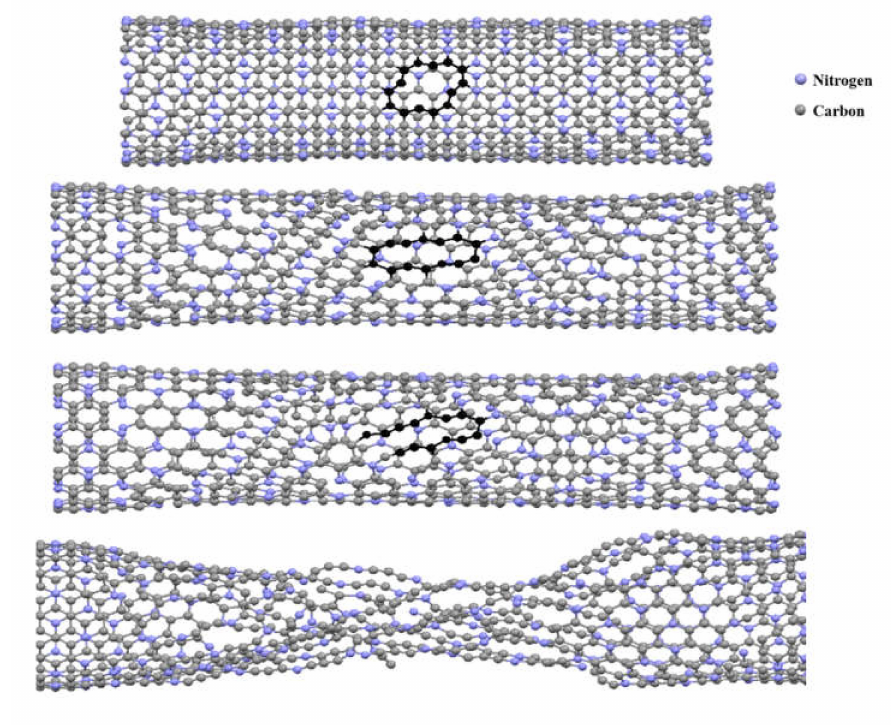
Figure 14. Snapshot of the failure process of a (10,10) armchair C 3 NNT with a two-atom vacancy